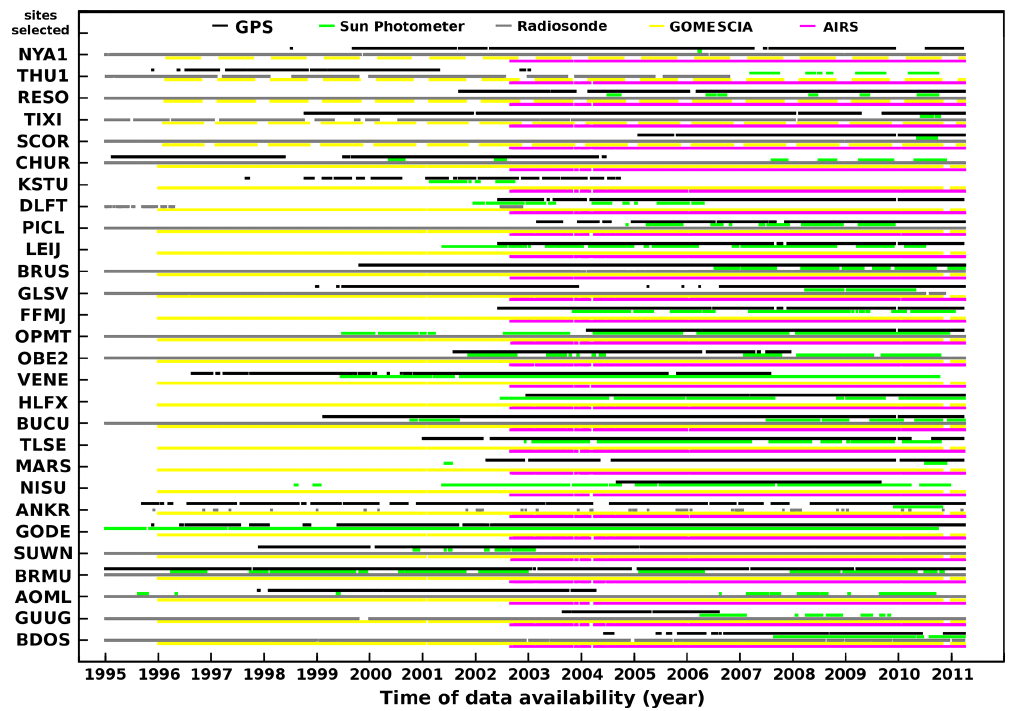
Figure 3. IWV data availability over the last 15 + years for the different instruments at the selected sites. Note that, for high latitudes, no GOMESCIA observations are available in winter due to high